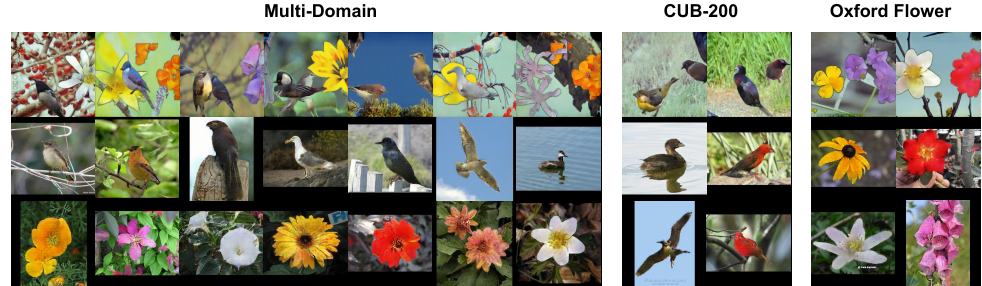
Figure 8. Examples of images generated by aRTIC GAN, trained over single and multiple domains. Examples of multiple-element generation are shown as well as of single birds and single flowers.